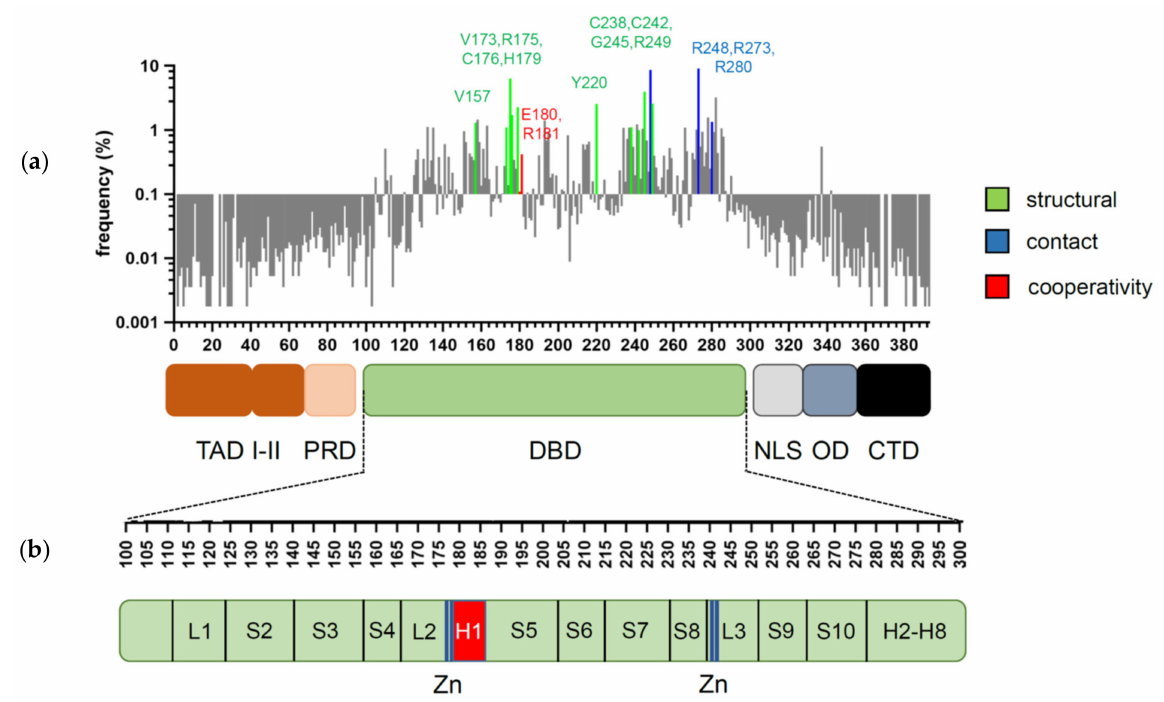
Figure 1. Domain structure of p53 and distribution of cancer-associated mutations. ( a ) Frequency and distribution of TP53 mutations detected in somatic tumors. Highlighted are the codons most frequently affected by structural (green), contact (blue), and cooperativity (red) mutations (references in text). ( b ) Secondary structure of p53 DBD. Residues responsible for zinc (Zn) ion coordination (blue) and H1 helix (red) are